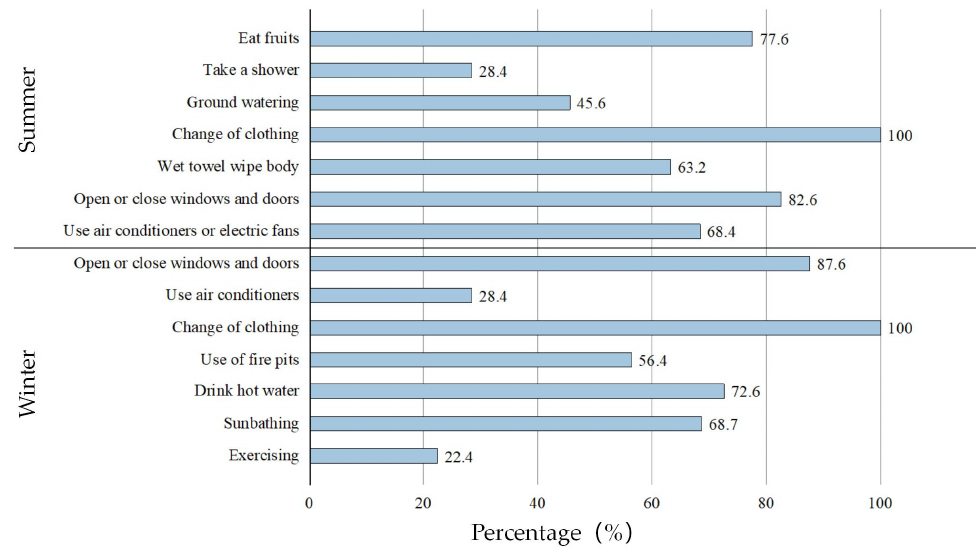
Figure 8. Statistics of residents’ thermal adaptive behavior.